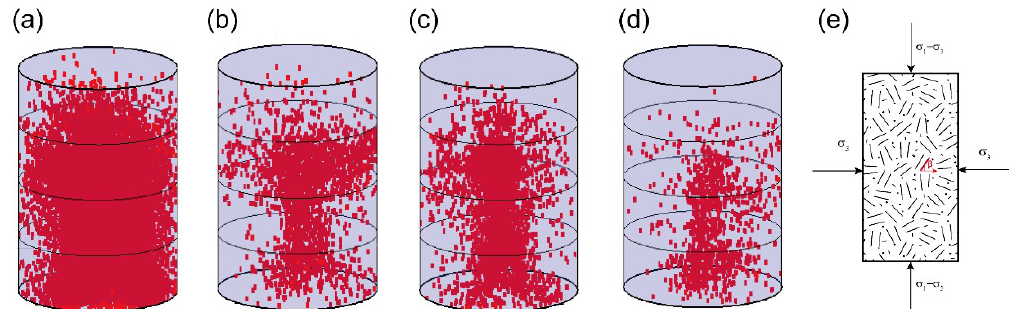
Figure 7. AE event maps of rock salt under different confining pressure during the triaxial loading test: ( a ) confining pressure of 5 MPa; ( b ) confining pressure of 10 MPa; ( c ) confining pressure of 15 MPa; ( d ) confining pressure of 20 MPa; and, ( e ) geometric relationship between micro-crack direction and stress